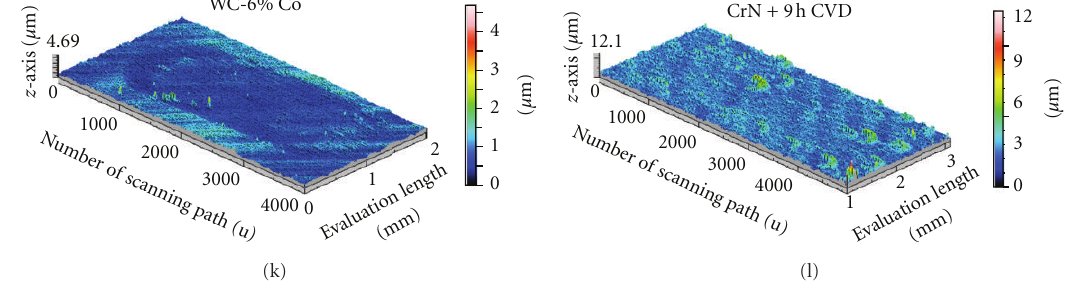
Figure 7: Wear tracks of uncoated, PVD- and CVD-coated samples.